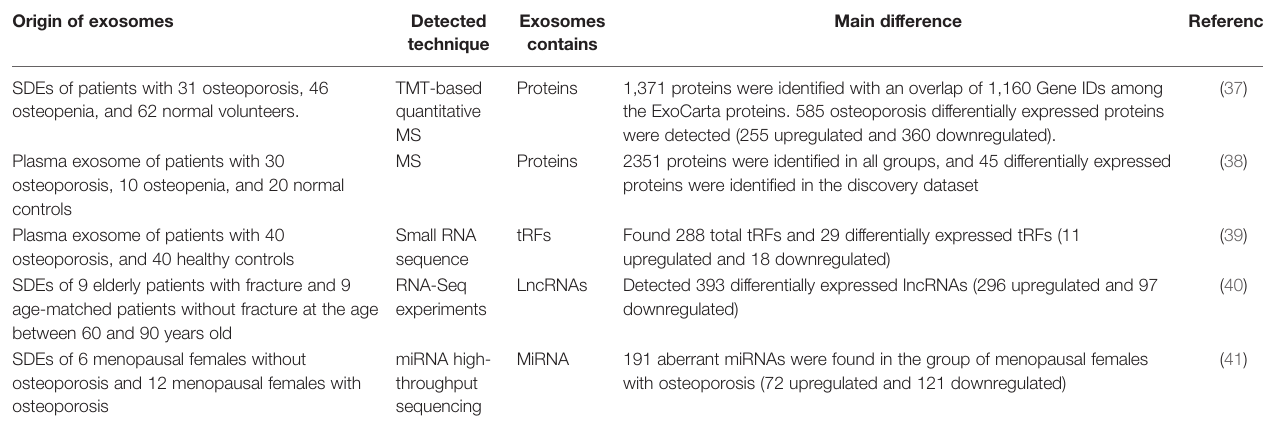
TABLE 1 | Exosomes from circulation in